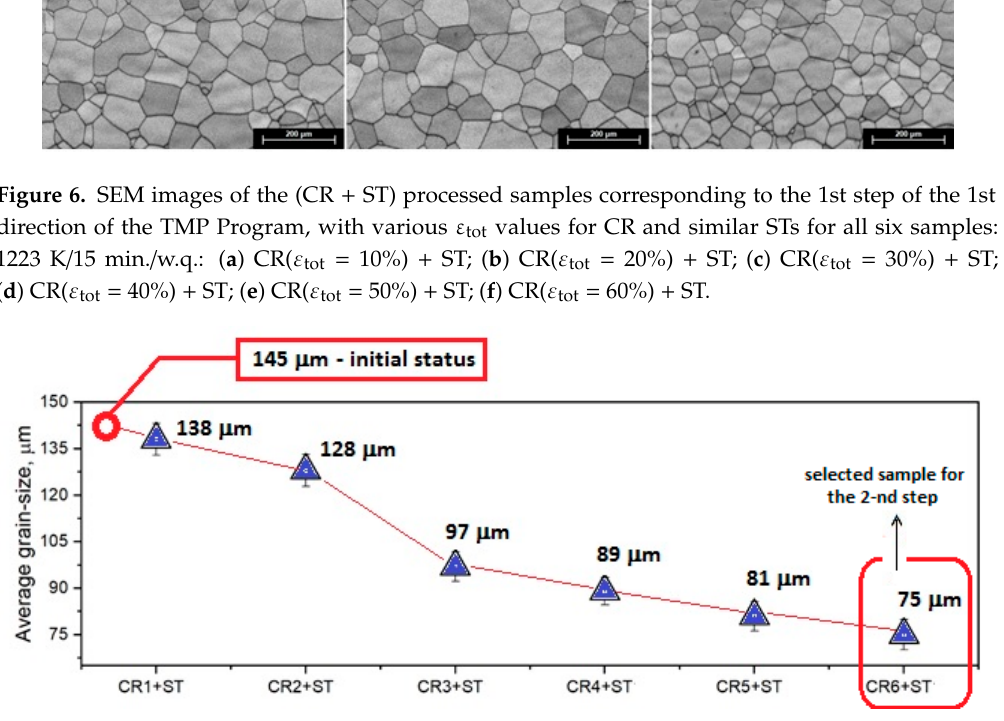
Figure 8. The SEM images of the (CR + solution treatment (ST) processed samples corresponding to the 2nd step of the 1st direction of the TMP Program with the same ε tot = 60% for the applied CR but with various STs: ( a ) CR + ST1 (1223 K/5 min./w.q.); ( b ) CR + ST2 (1223 K/10 min./w.q.); ( c ) CR + ST3 (1223 K/15 min./w.q.); ( d ) CR + ST4 (1223 K/20 min./w.q.).